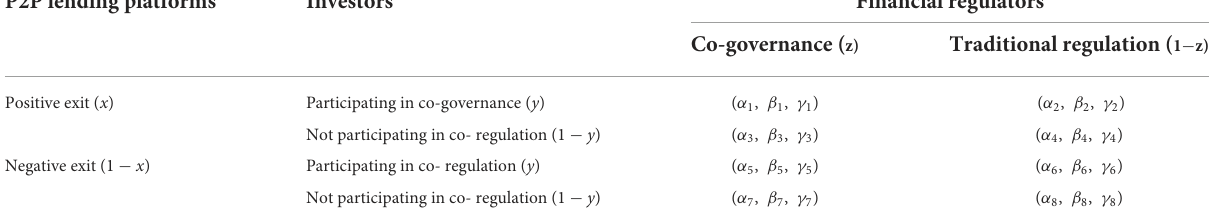
TABLE 1 The payoff matrix of the tripartite